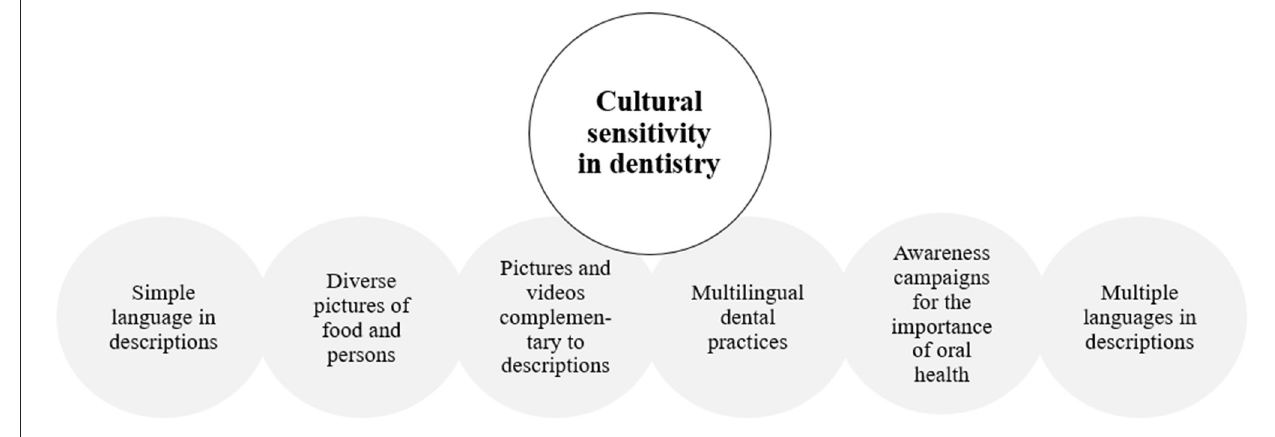
FIGURE 1 | Cultural sensitivity in dentistry.